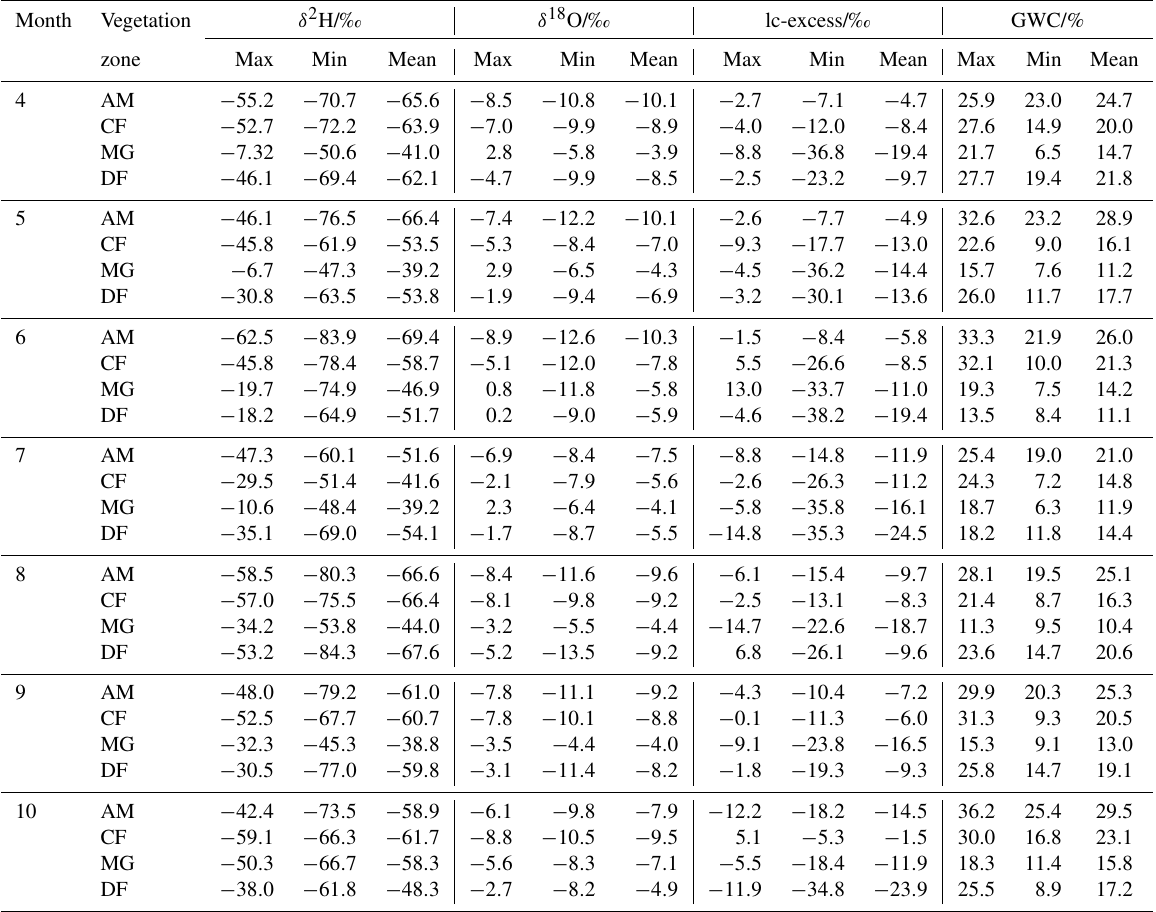
Table 3. General characteristics of soil water δ 2 H, δ 18 O, lc-excess and gravimetric water content (GWC) in different vegetation areas